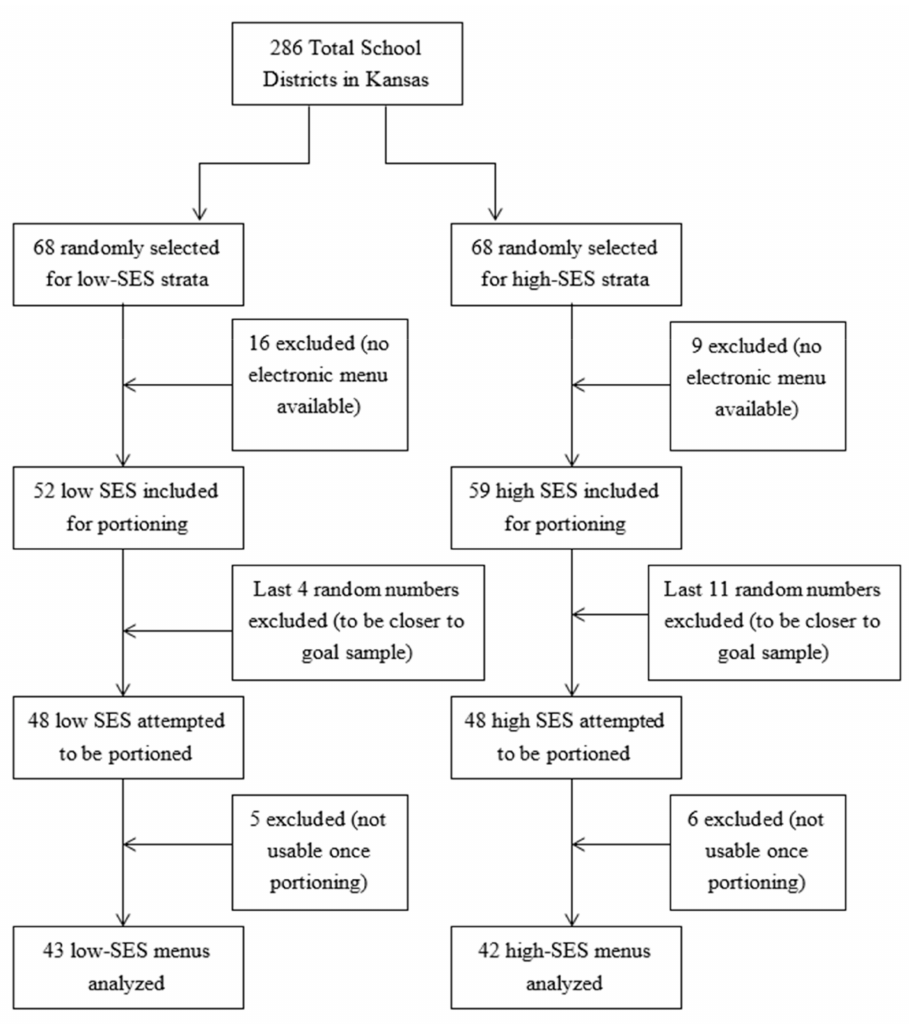
Figure 2. Flow chart of final sample selection and inclusion.